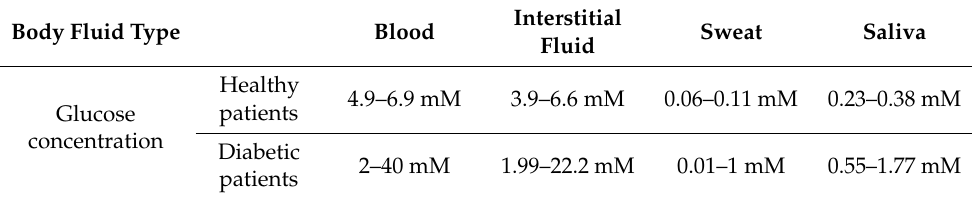
Table 1. Typical glucose concentrations in different types of human body fluids. Data from ref.